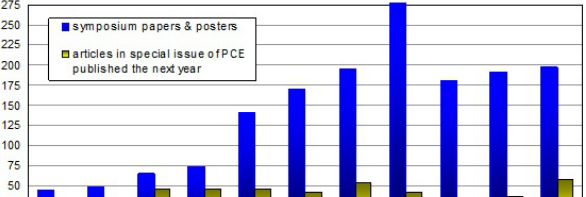
Table 3. The articles published in the WaterNet special issues of Physics and Chemistry of the Earth (2002–2010) represent a signif- icant share of all scientific papers on water-related issues in Africa.